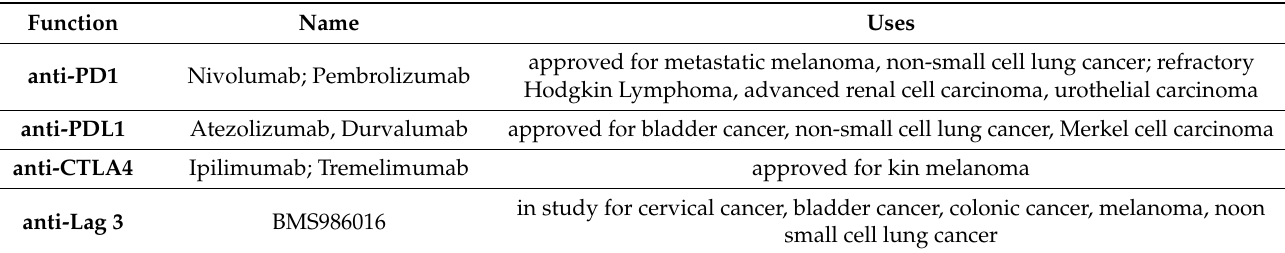
Table 1. Immune checkpoint